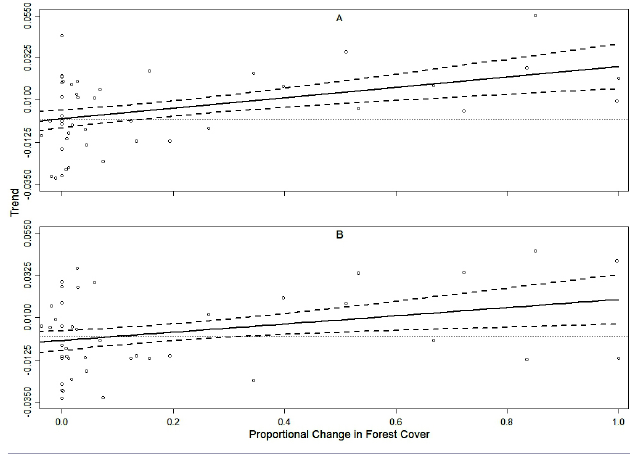
Fig. 3. Within-stand trends in abundance of Red-eyed Vireo (A) and Hermit Thrush (B) and predicted relationship (solid lines, with 85% confidence intervals [dashed lines]) with proportional change in forest cover between circa 1994 and 2014. Percent annual change can be derived by multiplying the y-axis by